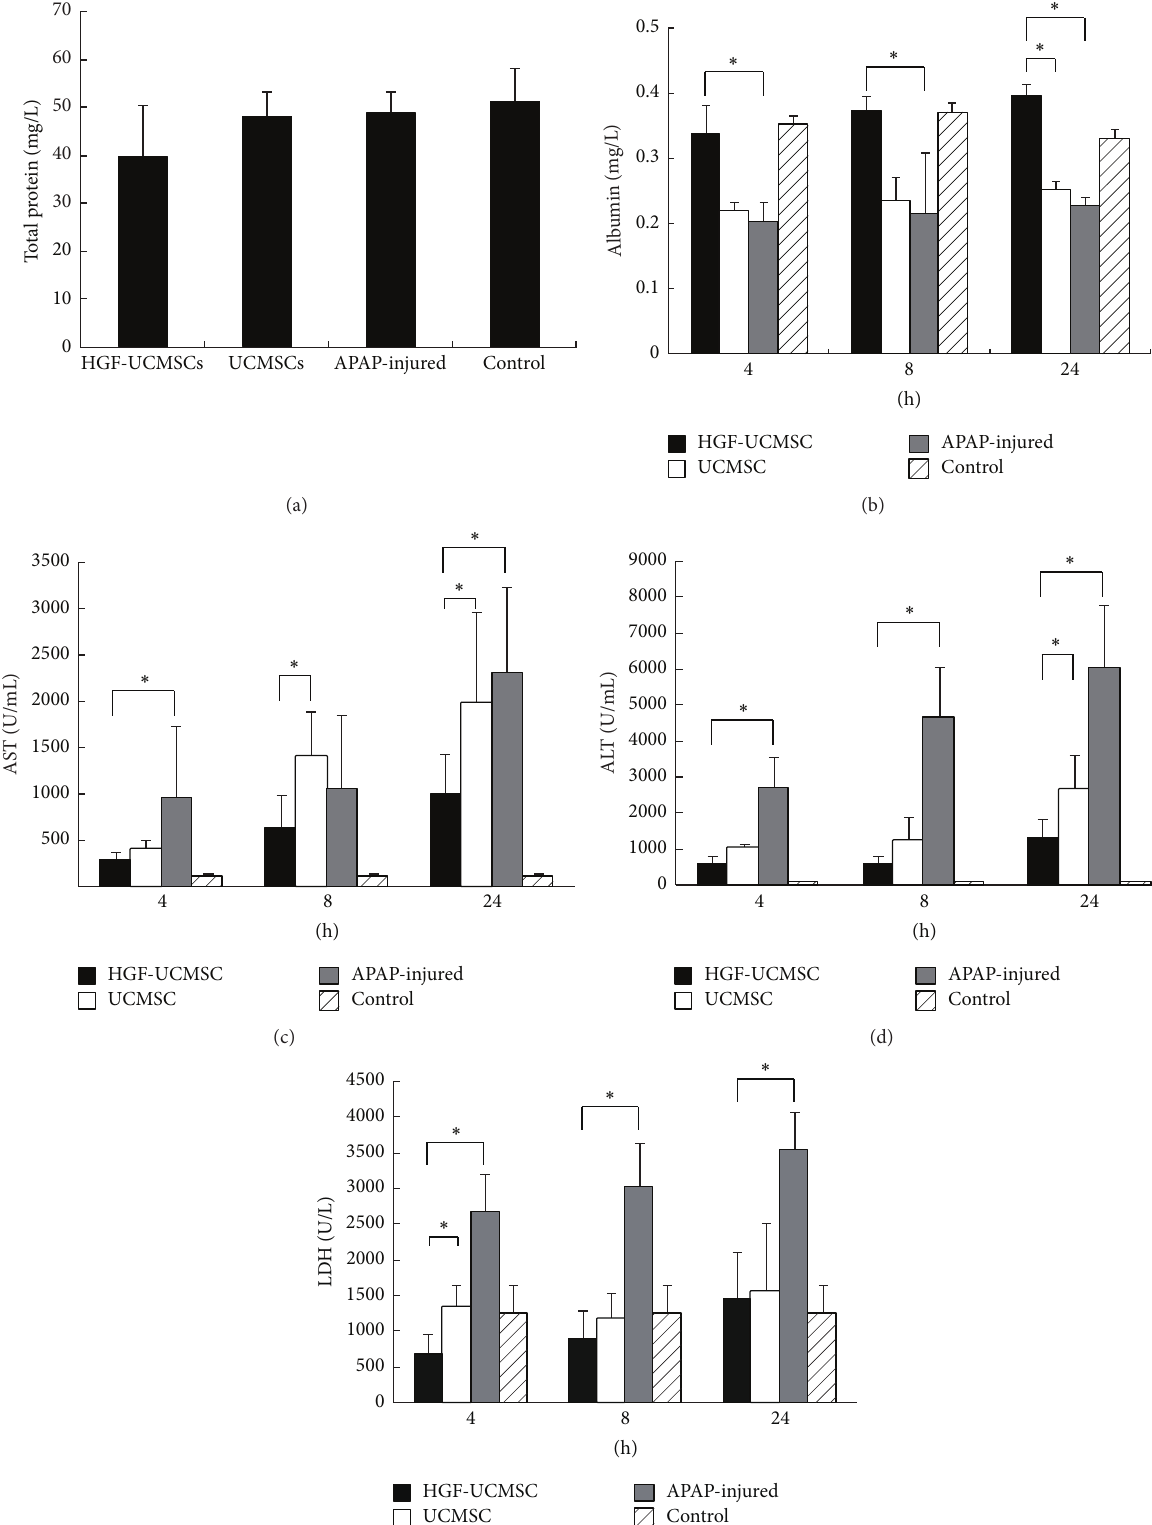
Figure 3: Hepatic function after transplantation of UCMSCs or HGF-UCMSCs. (a) Serum total protein in different groups at time point 24 h. (b) Serum albumin levels in different groups at different time points. (c–e) Biochemical analysis of aspartate aminotransferase (AST), alanine transaminase (ALT), and lactate dehydrogenase in serum. The data are expressed as the means ± SD of three independent experiments. ∗ 𝑃 < 0.5 compared with the